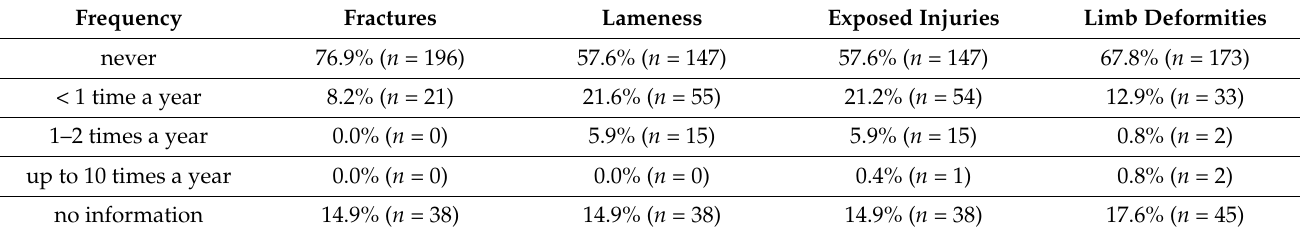
Table 10. Observation of the owners: frequency of diseases or symptoms affecting the musculoskeletal system ( n =